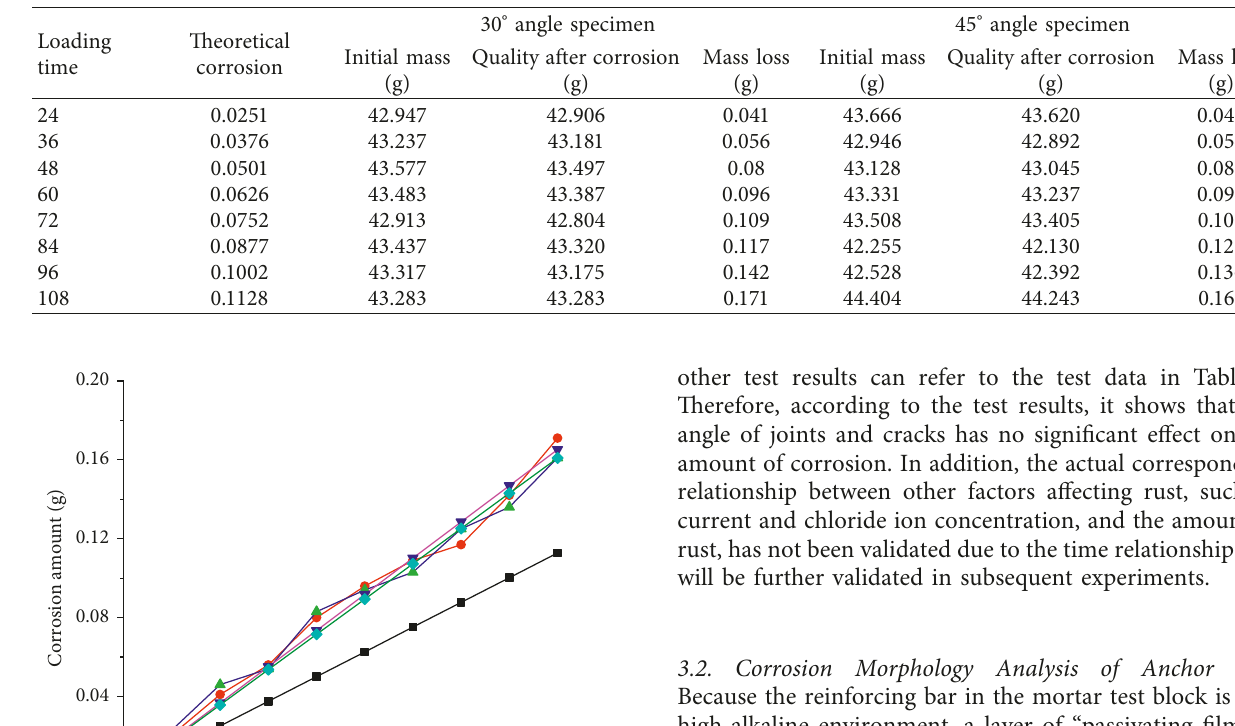
Table 3: Test quality record.